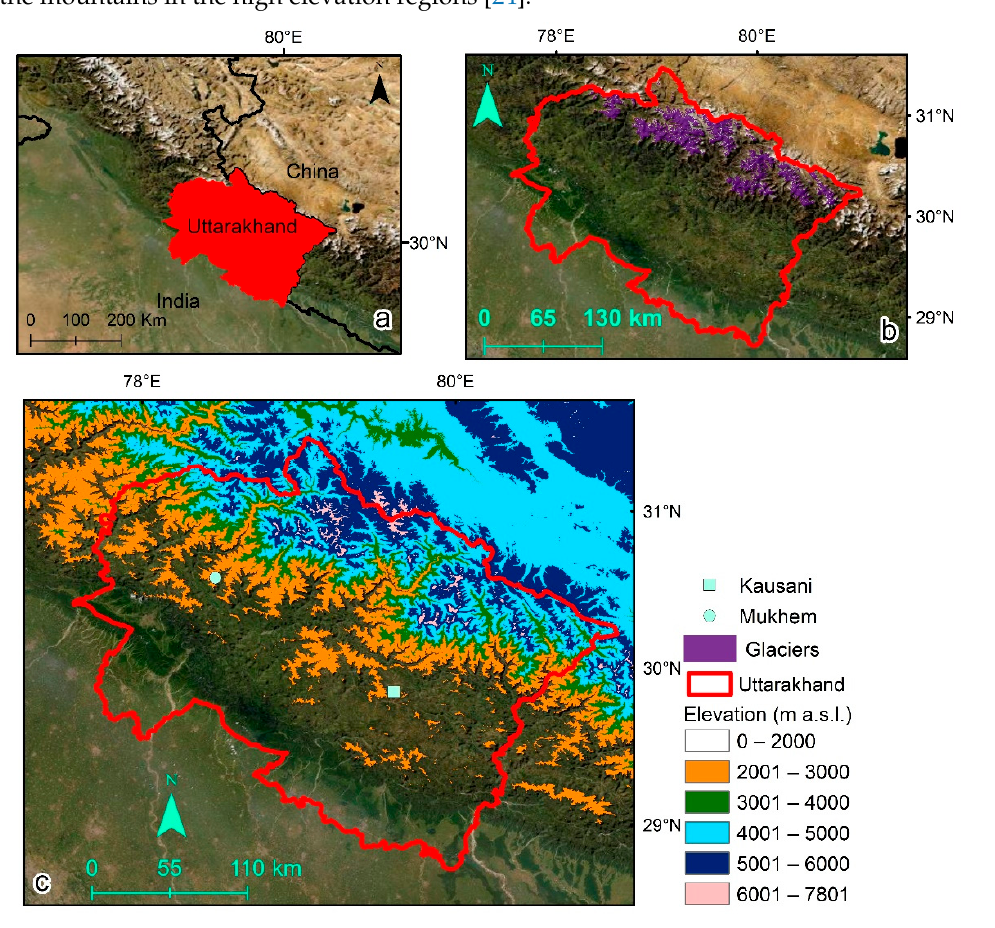
Figure 1. ( a ) Area in red shows Uttarakhand inside the map of India. ( b ) Political boundary of Uttarakhand is delineated in red. All glaciers located within the political boundary of Uttarakhand are shown in purple. Glacier boundaries are accessed through Randolph Glacier Inventory [25]. Base-map layer [26] fills the background. ( c ) Multiple colour legends highlight different elevation classes in Uttarakhand. Two locations, Kausani and Mukhem, in Uttarakhand are shown.